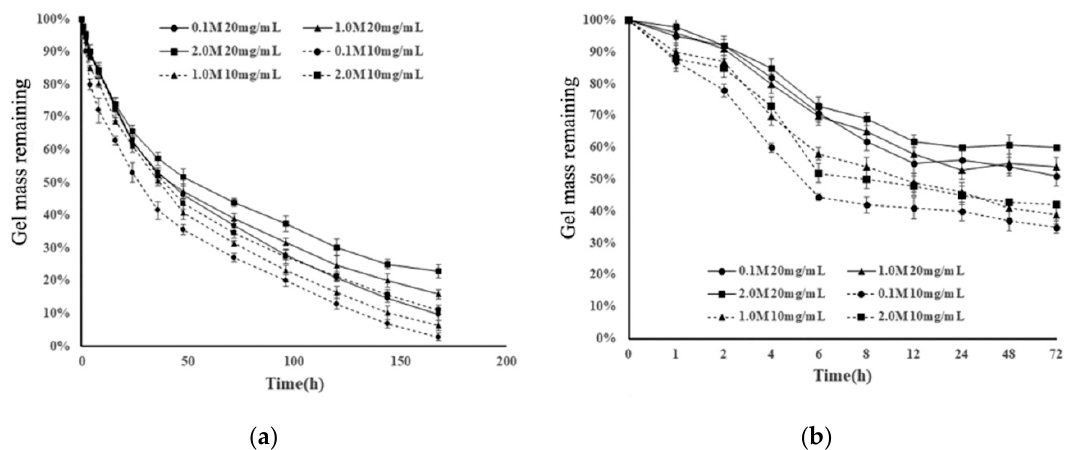
Figure 25. In vitro degradation of HA-SH-Ac-HA hydrogels by hyaluronidase ( a ) and by DTT ( b ). Reproduced from [136], with permission from Royal Society of Chemistry, 2020.